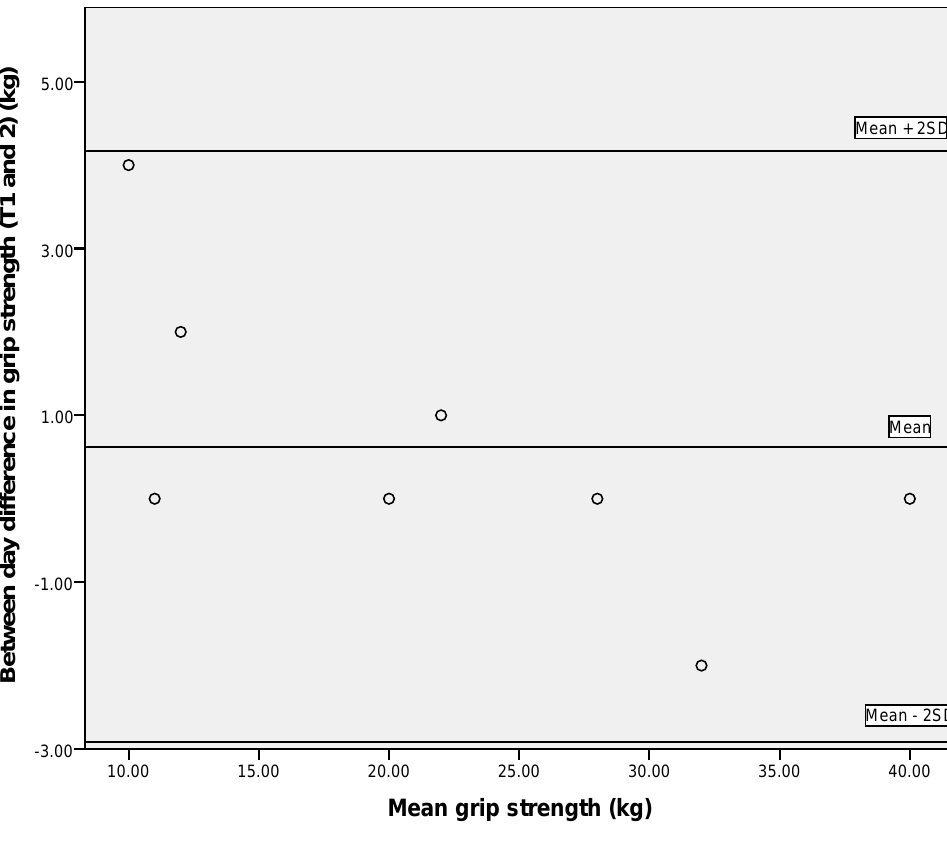
Figure 3. Bland–Altman plot showing between day variation for grip strength.